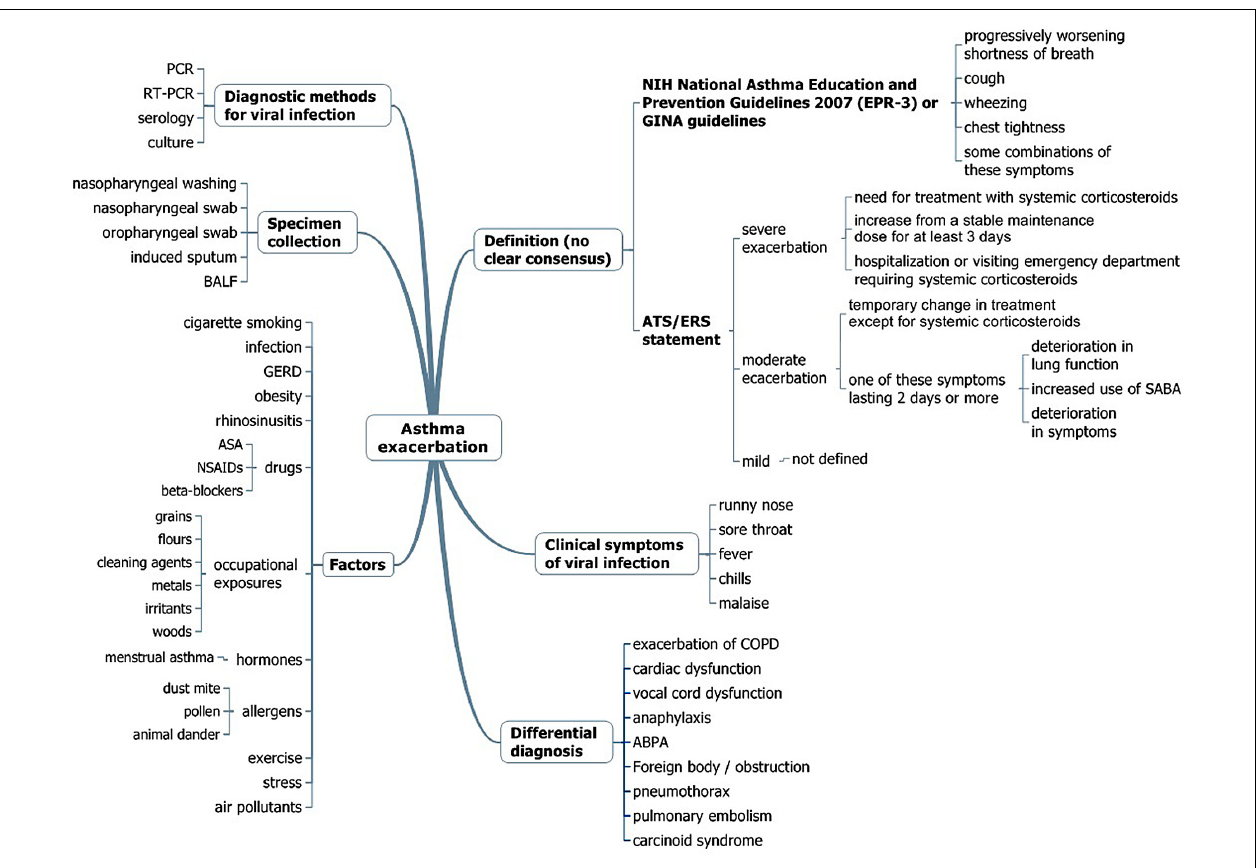
FIGURE 3 | Multidisciplinary assessment for asthma exacerbation. PCR, polymerase-chain reaction; RT-PCR, real-time PCR; BALF, bronchoalveolar lavage fluid; GERD, gastroesophageal reflux disease; ASA, acetylsalicylic acid;